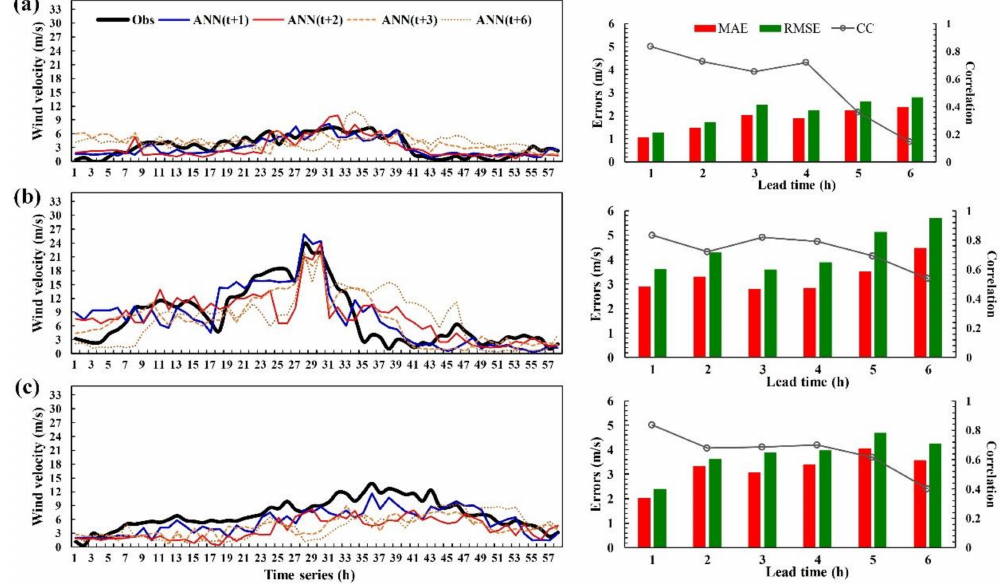
Figure 11. Comparisons between records and 1- to 6-h lead predictions for Fanapi in 2010: ( a ) Hsinchu, ( b ) Wuqi, and ( c ) Kaohsiung Stations.